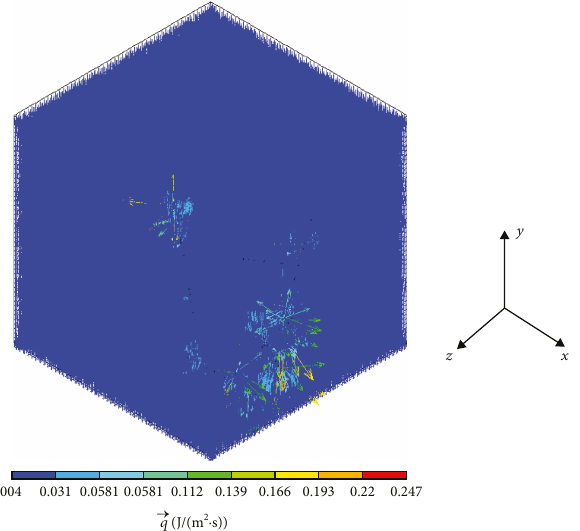
Figure 34: Heat fl ow vector of depositing on the fi ber with the carbon model. Table 4: Thermal conductivity coe ffi cient of fi ber dimension. Model type